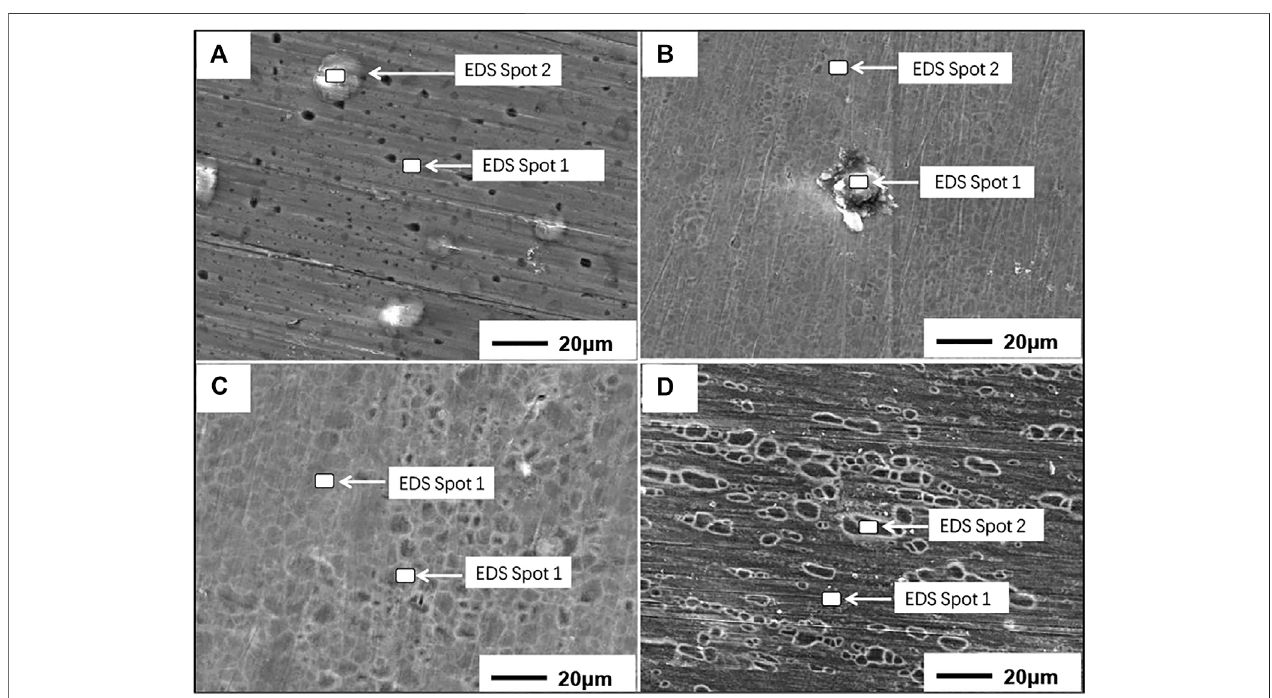
FIGURE 1 | The oxides morphologies of different samples: (A) pure Mg; (B) Mg-3Y; (C) Mg-5Y; (D) Mg-7Y.